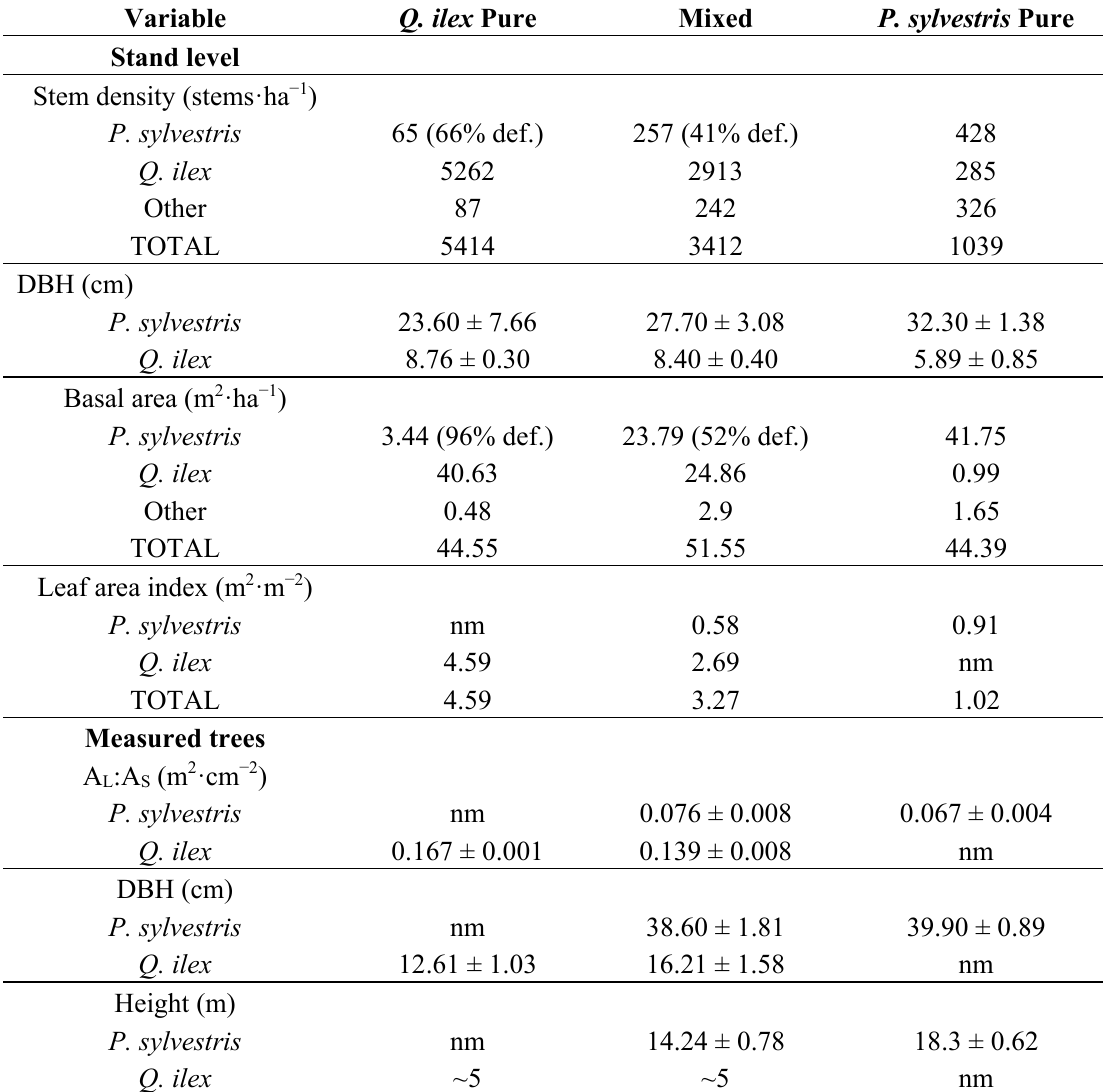
Table 1. Main characteristics (mean ± SE) of the three stands studied in the Tillar